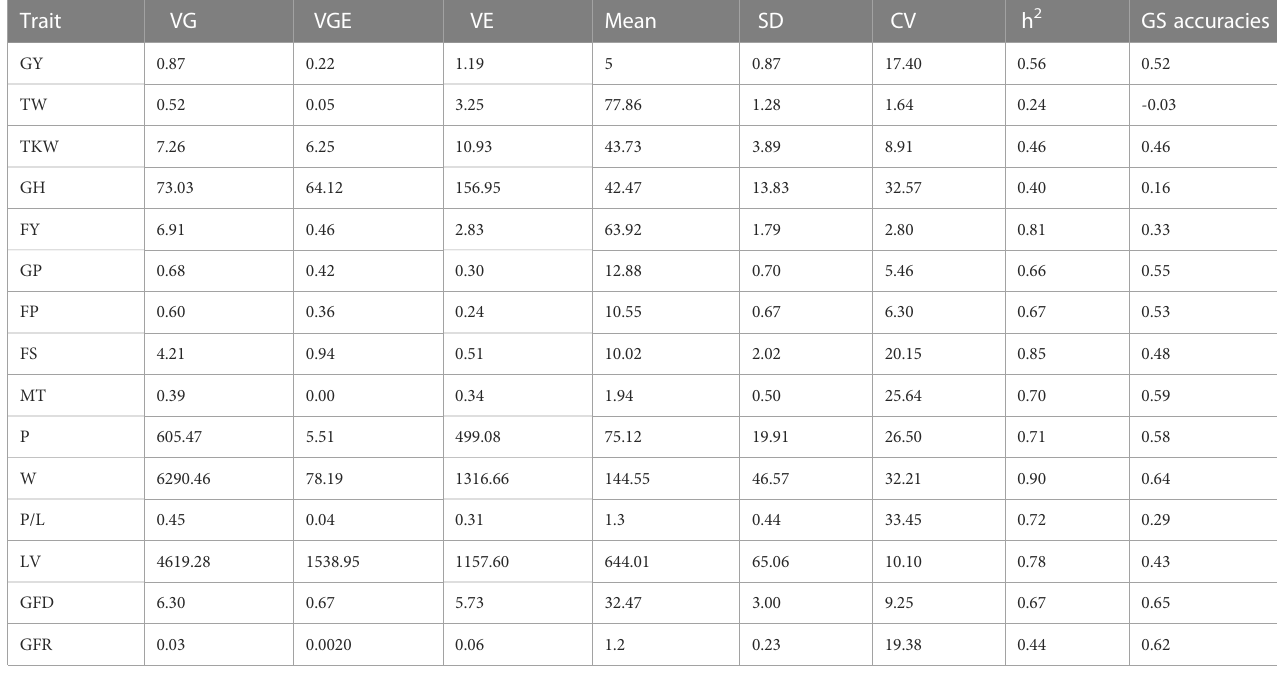
TABLE 1 Trait performance across environments.